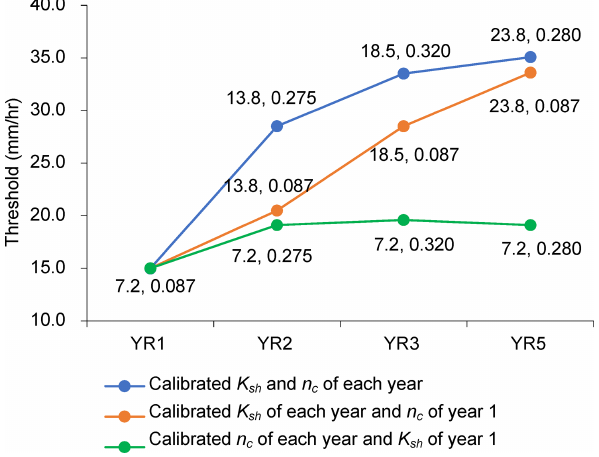
Figure 8. The ROC-based thresholds for I 75 ferent model settings. Pairs of K sh (saturated hydraulic conductivity on hillslopes) and n c (Manning’s n in channels) in each model are given along with the data points.